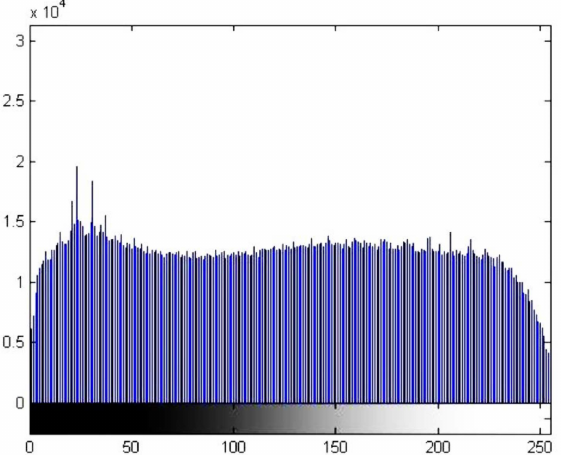
Figure 6. Histogram after performing global histogram adaptation and equalization using the exponential method for the image in Figure 2 (zone